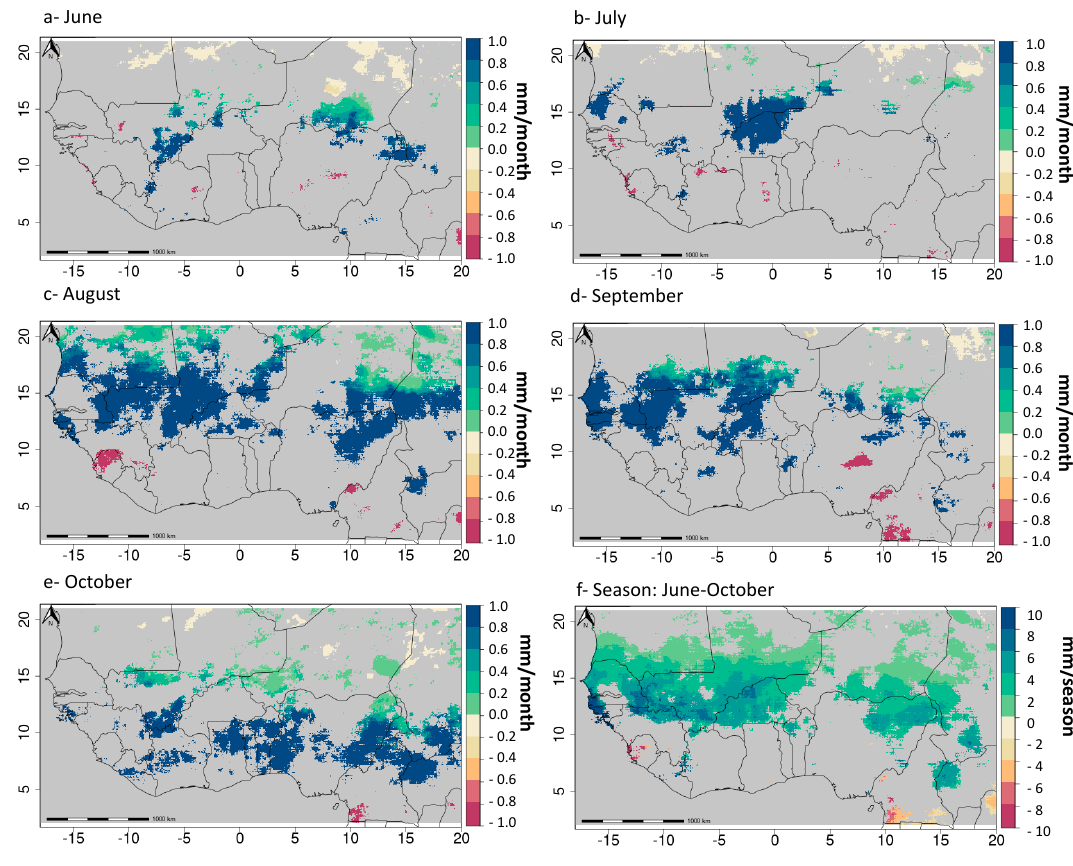
Figure 2. Precipitation regressions for the months of June ( a ), July ( b ), August ( c ), September ( d ), October ( e ), and full season ( f ) from 1981 to 2016, in mm/month for ( a ) through ( e ), and in mm/season for ( f ). The data in ( a – e ) is capped at − 1 to 1 mm, and the data in ( f ) is capped at − 10 to 10 mm. Any insignificant trend ( p > 0.05) has been masked out in gray.